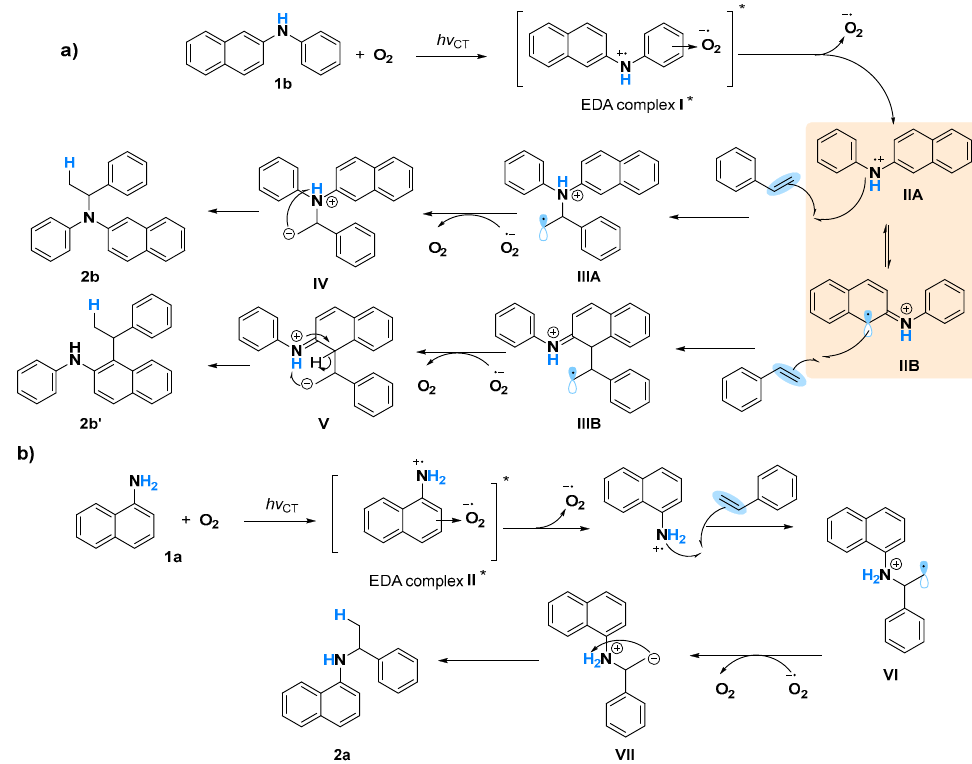
Figure 5. Proposed mechanism for photoinduced amination reactions using ( a ) 1b , and ( b ) 1a